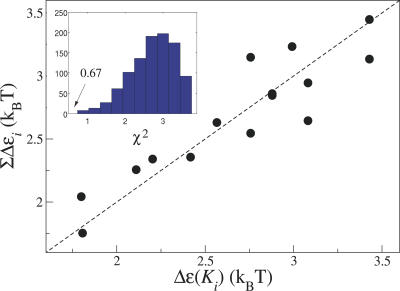
Additivity of Offset Energies from Four Modification SitesTest of additivity of the contributions of the four modification sites to the total offset energy Δ∈, based on the in vitro data for 15 receptor modification states (all possible combinations of Es and Qs, except EEEE) from Table I of [13]. Horizontal axis, Δ∈ obtained from experimental Ki values (see Methods); vertical axis, Δ∈ determined from the sum of the offset energies from the four individual modification sites Δ∈i treated as χ2 fitting parameters (see Methods). Inset, histogram of χ2 values after minimization for 1,000 randomized permutations of the data; χ2 = 0.67 of the unrandomized data is the lowest χ2 (see Methods).